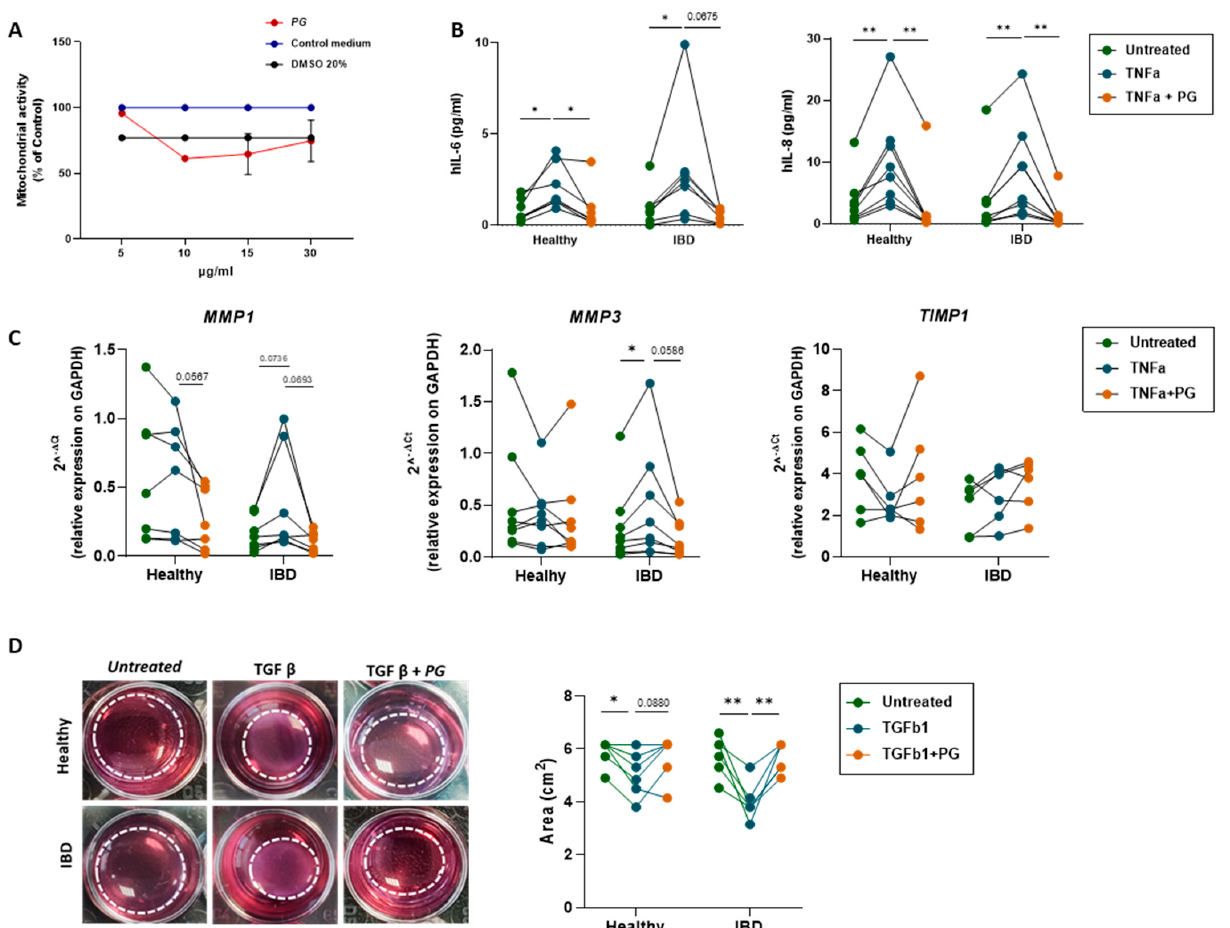
Figure 6. PG reverted fibroblast activation, decreasing inflammatory cytokines, MMP expression, and the contractile phenotype. ( A ) MTT assay was performed on primary intestinal fibroblasts isolated from noninflamed and inflamed areas of IBD patients after stimulation with PG at different concentration (5, 10, 15, 30 µ g/mL) for 48h. Primary fibroblasts untreated or stimulated with 20% DMSO were used as control. ( B ) IL-6 and IL-8 levels ( PG /mL) in healthy and IBD fibroblasts treated for 48h ± TNF- α or TNF- α + PG . ( C ) Quantitative Real-Time PCR analysis of MMP1 , MMP3, and TIMP1 mRNA expression in healthy and IBD fibroblasts stimulated ± TNF- α or TNF- α + PG . Gene expression was normalized to GAPDH . ( D ) Representative images of contraction assay performed on healthy and IBD fibroblasts stimulated ± TGF- β or TGF- β + PG . The collagen circles are highlighted by the dashed white line. The circle area (cm 2 ) was measured in healthy and IBD fibroblasts stimulated ± TNF- α or TNF- α + PG . Data are presented as mean ± SEM. Paired t -test * p < 0.05, ** p < 0.01. n = 8 healthy/group, n = 8 IBD (5 CD and 3